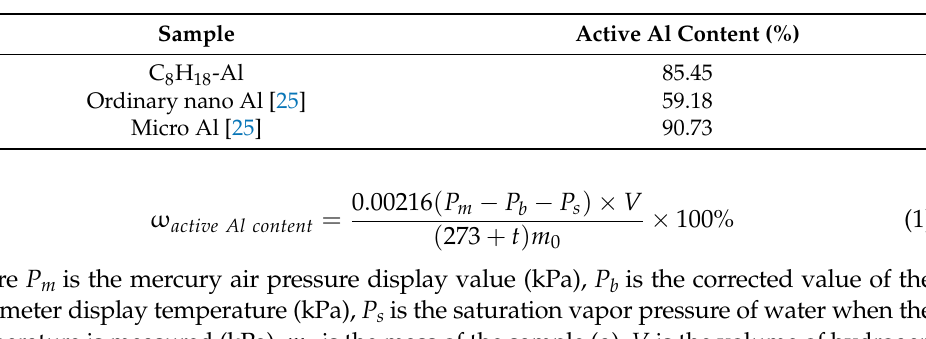
Table 1. Testing results of active Al content.